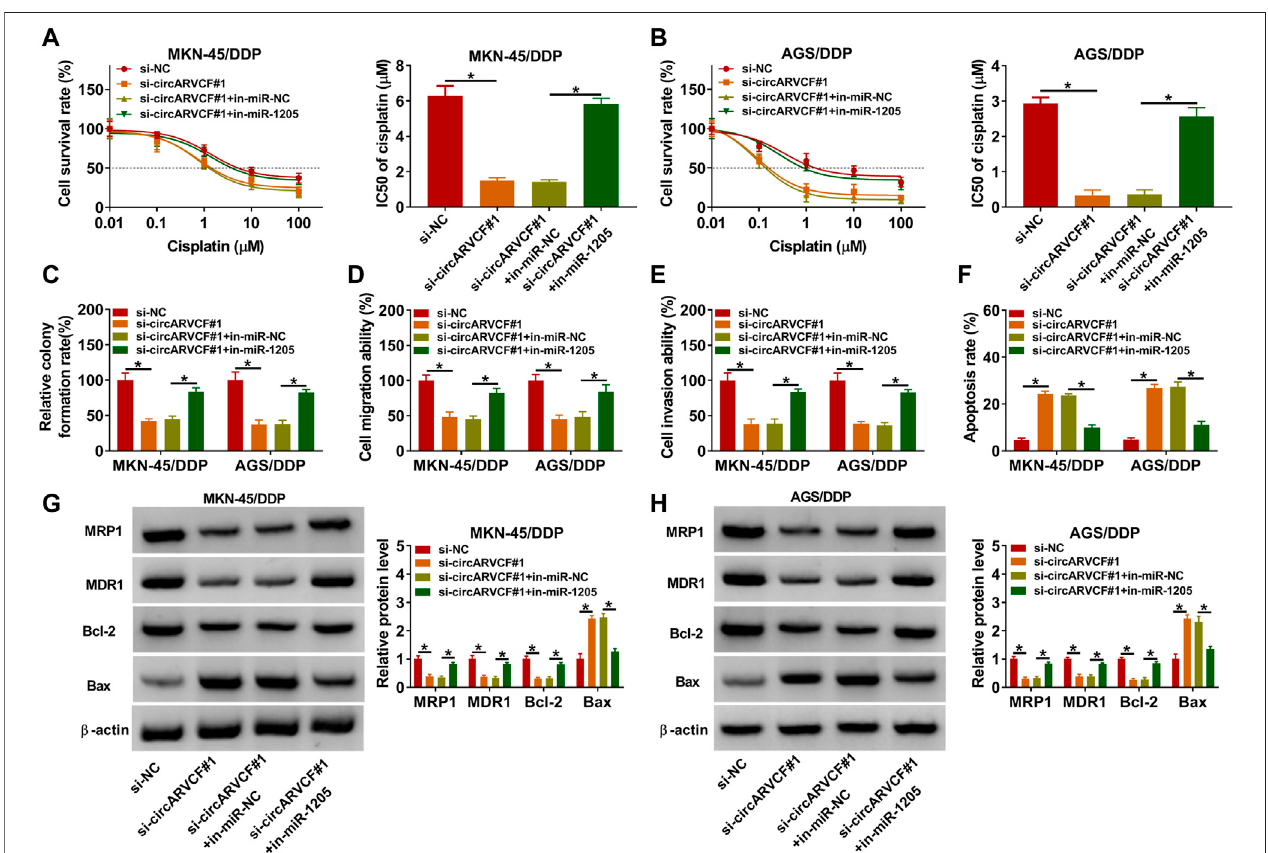
FIGURE 4 | Inhibition of miR-1205 reversed the effects of circARVCF knockdown on DDP resistance, cell colony formation, migration, invasion, and apoptosis in DDP-resistant GC cells. MKN-45/DDP and AGS/DDP cells were transfected with si-NC, si-circARVCF#1, si-circARVCF#1+in-miR-NC, or si-circARVCF#1+in-miR- 1205. (A,B) IC50ofcisplatinwasestimatedbyCCK-8assay. (C) ThecolonyformationofMKN-45/DDPandAGS/DDPcellswasexaminedwithcolonyformationassay. (D,E) The migration and invasion of MKN-45/DDP and AGS/DDP cells were assessed by transwell assay. (F) The apoptosis of MKN-45/DDP and AGS/DDP cells wasanalyzed by fl owcytometry analysis. (G,H) The protein levels ofMRP1, MDR1, Bcl-2 and Baxin MKN-45/DDP and AGS/DDP cells weremeasured via western blot assay. * p <